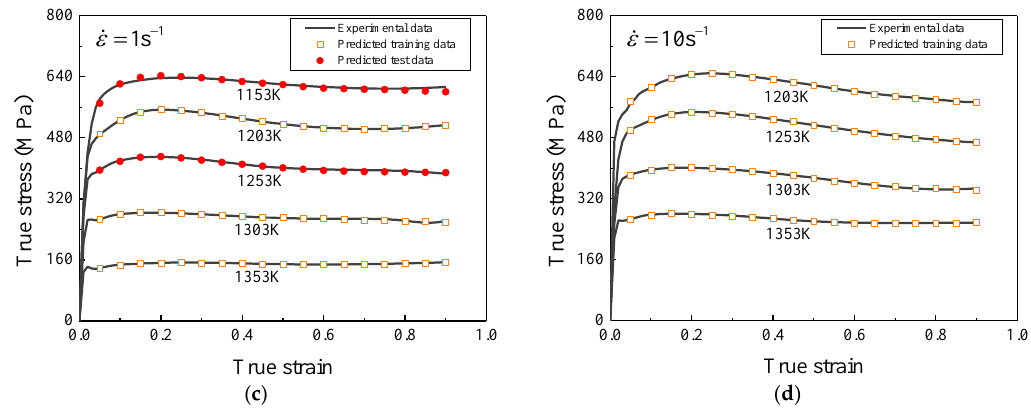
Figure 9. The comparisons between the experimental and predicted true stress by the ANN model at different temperatures and the strain rates of ( a ) 0.01 s −1 ; ( b ) 0.1 s −1 ; ( c ) 1 s −1 and ( d ) 10 s −1 .